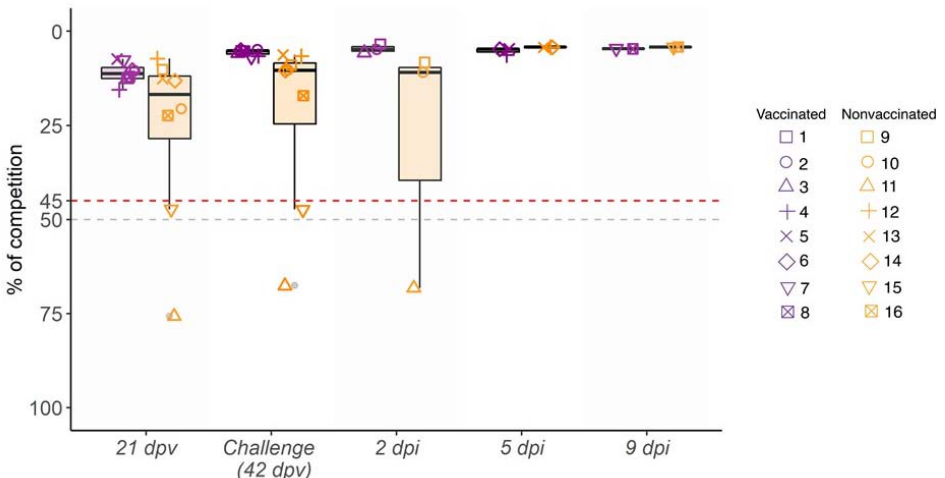
Figure 2. Kinetics of antibody levels against SIV NP in serum samples collected from 21 dpv to 9 dpi. Percentage of competition (%) and the day of sampling are represented in ordinate and abscissa axes, respectively. Violet indicates vaccinated animals, whereas the nonvaccinated group is indicated in orange box plots, where whiskers indicate quartiles’ variability. Each animal ID is represented by different shapes. Values plotted as the upper red line (<45%) are considered positive, whereas values of the lower gray line (>50%) are considered negative. Values between both lines (45% and 50%) are considered doubtful. Table 1. HI activity of sera against challenge strain A/Swine/Spain/SF32071/2007